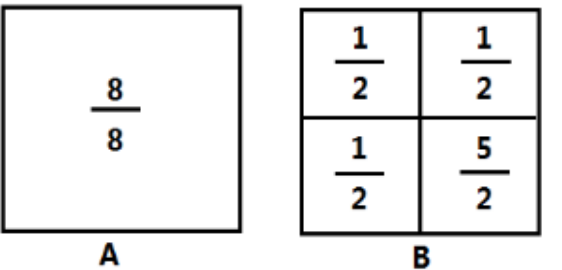
Figure 3. Schematic diagram of true mean AGB scale invariance. ( A ) the mass of the AGB per unit surface area of coarse resolution remote sensing data; ( B ) the mass of the AGB per unit surface area of high resolution remote sensing data.